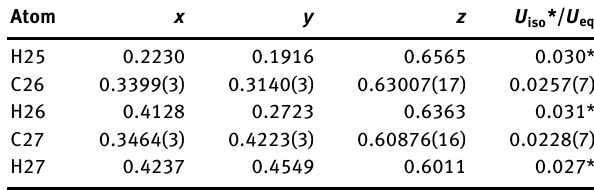
Table 2: Fractional atomic coordinates and isotropic or equivalent isotropic displacement parameters (Å 2